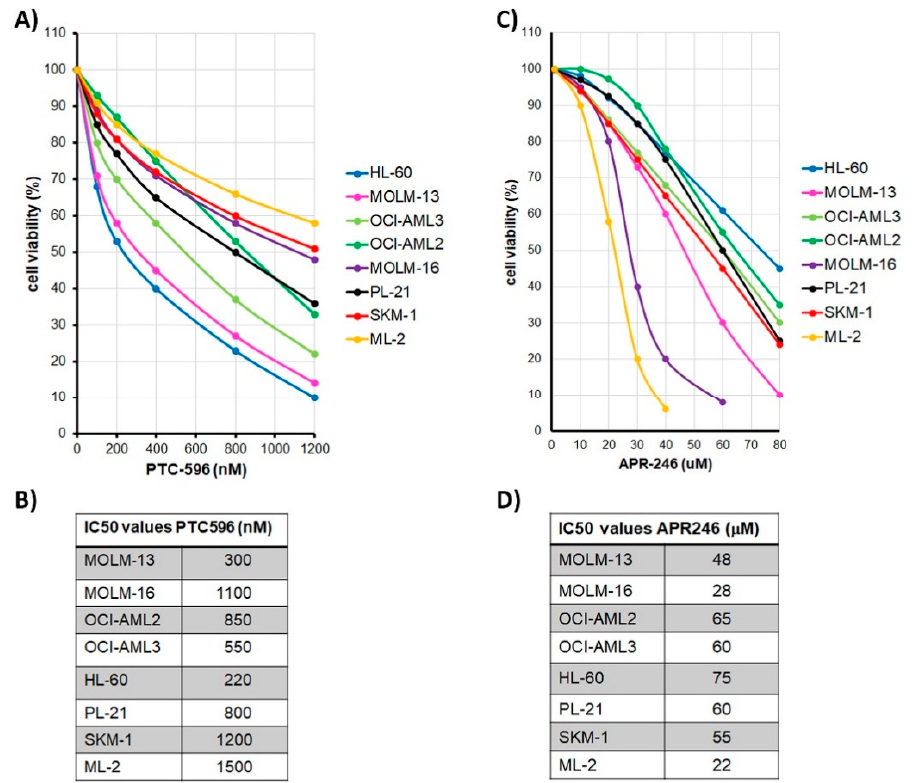
Figure 1. Dose response of AML cell lines treated with PTC596 or APR-246. Dose response curves and IC50 values in AML cell lines treated with PTC596 ( A , B ) and APR-246 ( C , D ). Cell viability data are average values of multiple repeat measurements per dosage. Standard deviation was 3–6%.